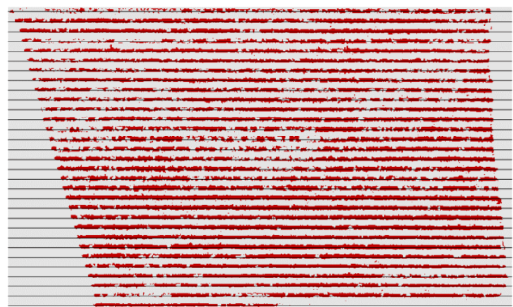
Figure 6. Orchard rows (lines) detected in the treed region image for